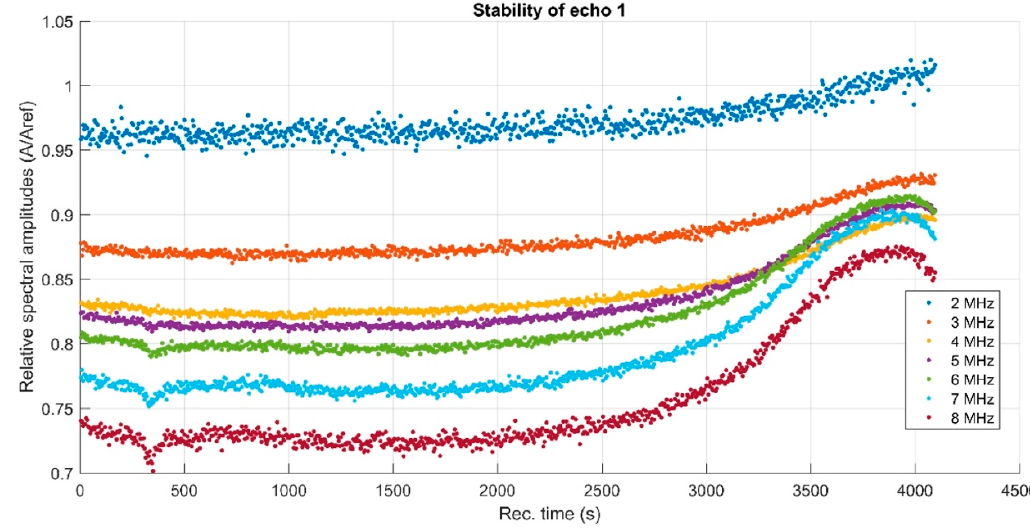
Figure 4. Spectral amplitudes relative variation vs. time, for the first echo.